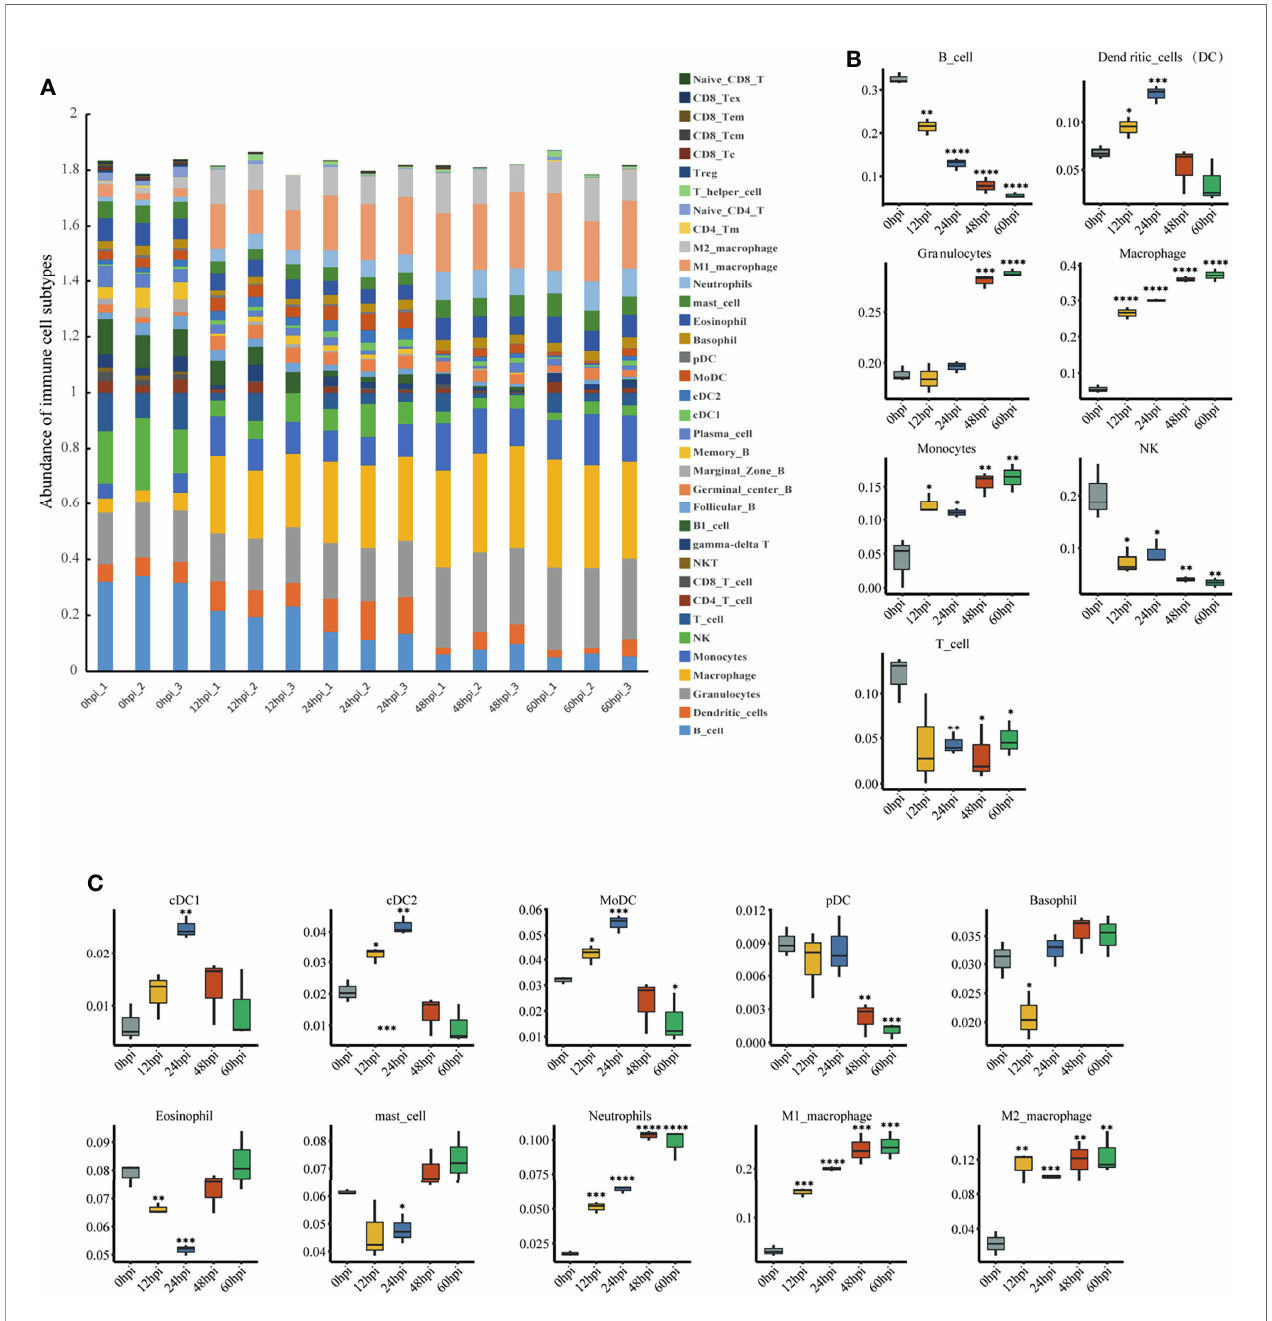
FIGURE 6 | Immune cell in fi ltration analysis via ImmuCellAI-mouse. (A) Abundance of 36 immune cell types in all samples. (B) Abundance of the seven major immune cell types in layer 1 at different infection stages. (C) Abundance of 10 subtypes of the three major innate immune cell types in layer 2 at different infection stages. *P < 0.05, **P < 0.01, ***P < 0.001, ****P < 0.0001, compared with 0